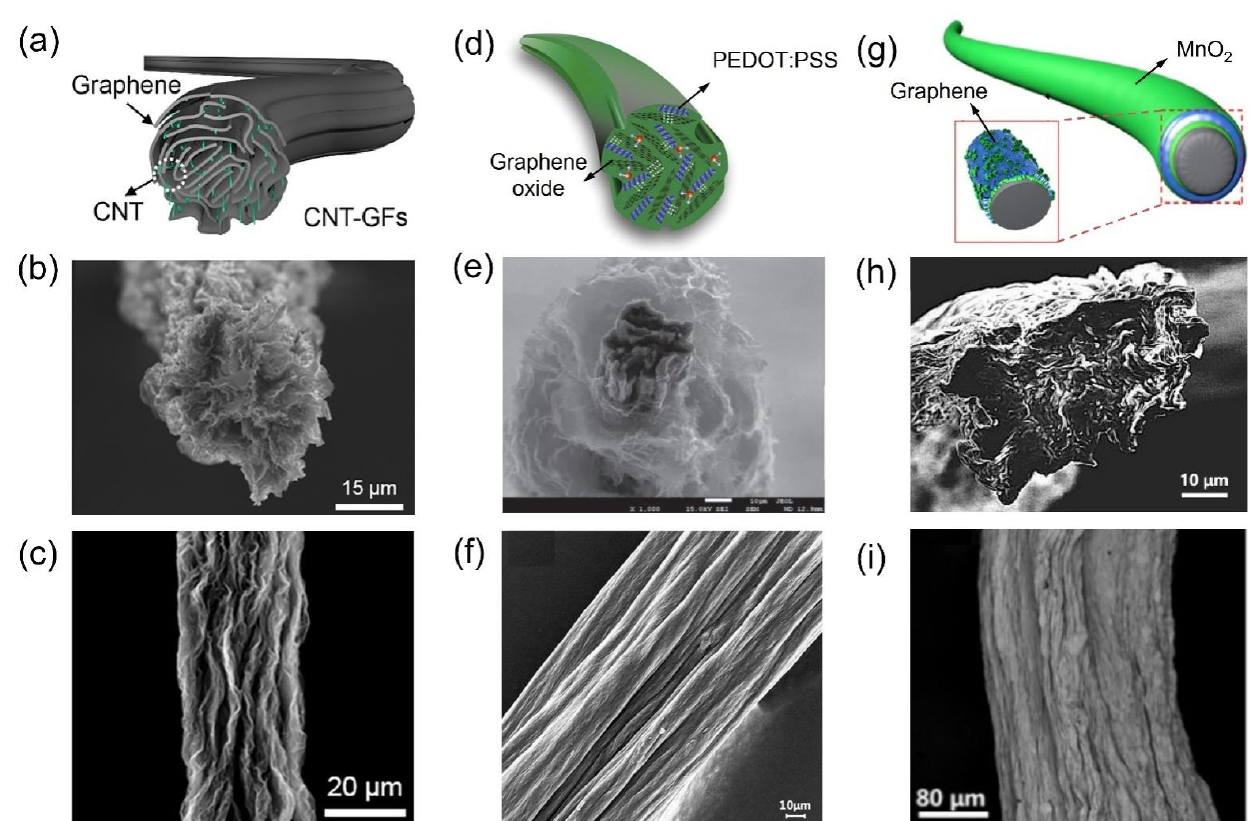
Figure 1. ( a ) Schematic, ( b ) surface SEM image, and ( c ) cross section SEM image of graphene/CNT composite fiber [55] (copyright permission American Chemical Society 2019); ( d ) Schematic, ( e ) surface SEM image, and ( f ) cross section SEM image of graphene/PEDOT:PSS composite fiber [58,59] (copyright permission Elsevier 2018, Wiley-VCH 2013); ( g ) Schematic, ( h ) surface SEM image, and ( i ) cross section SEM image of graphene/MnO 2 composite fiber [60,61] (copyright permission Elsevier 2021, Wiley-VCH 2020).